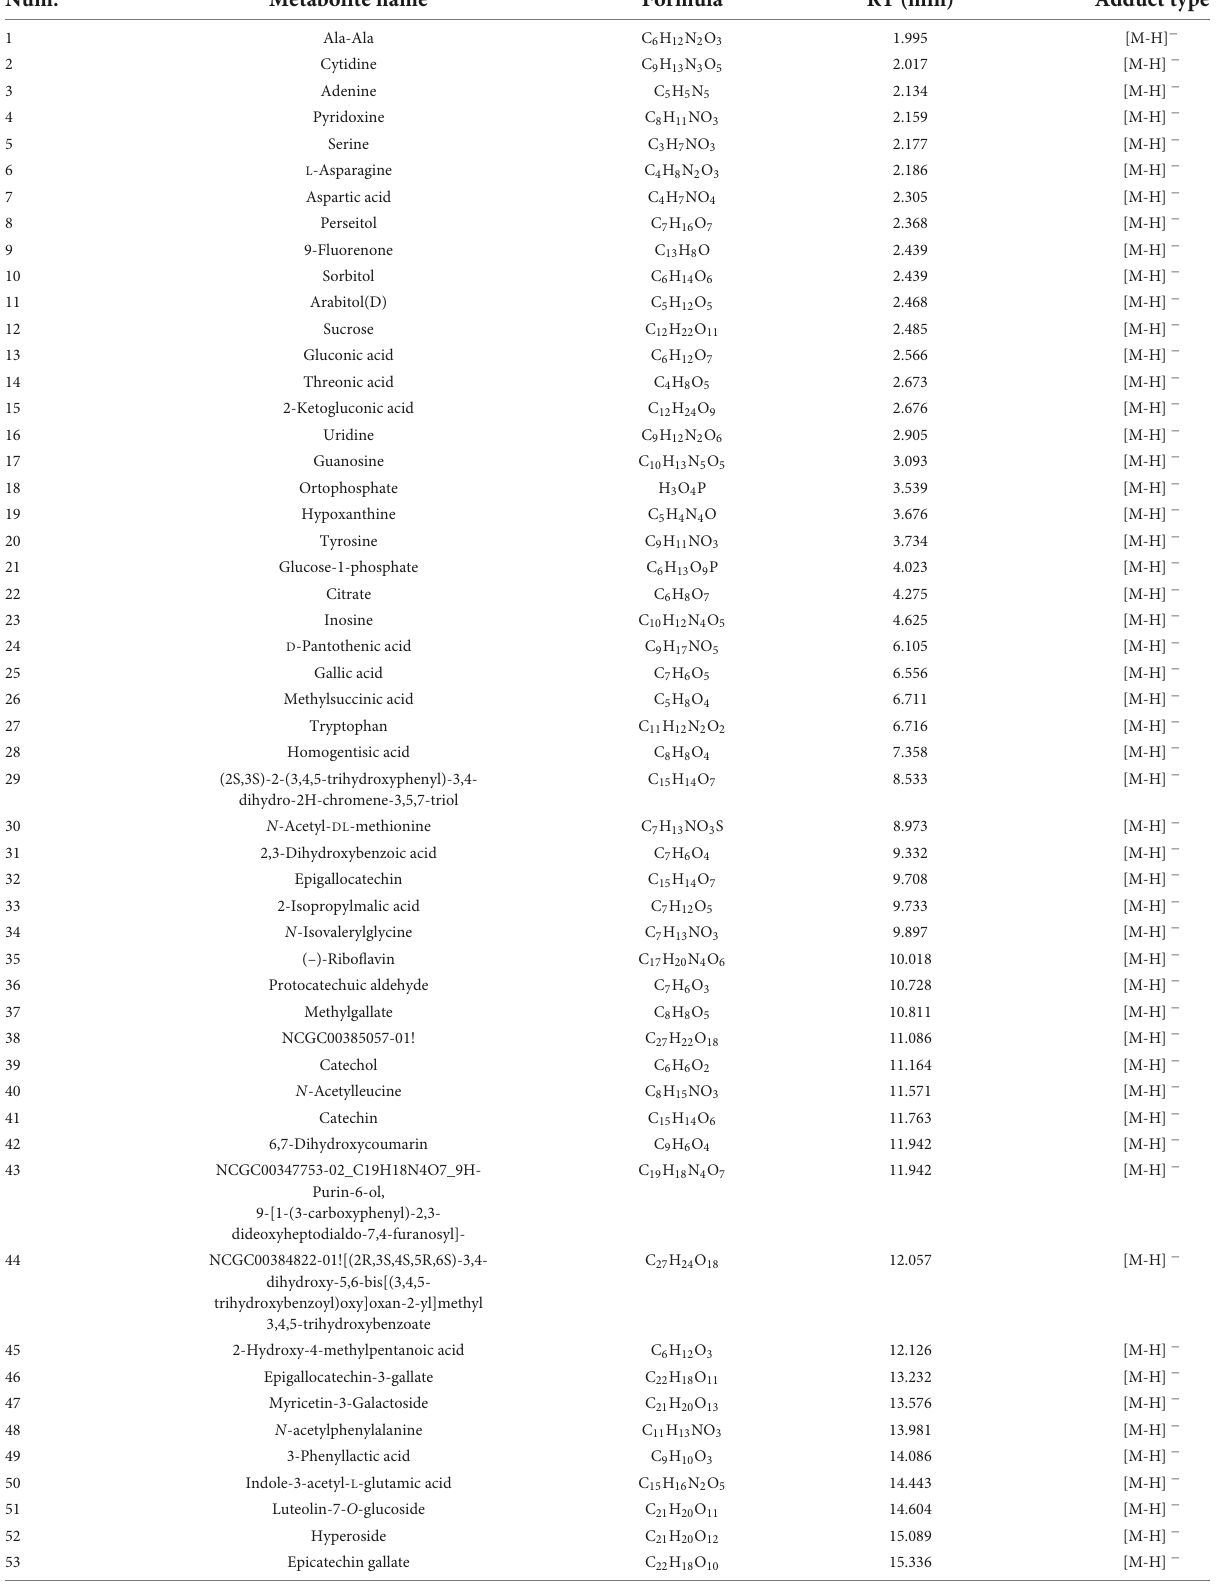
TABLE 1 Metabolites of both WT and HL seeds.